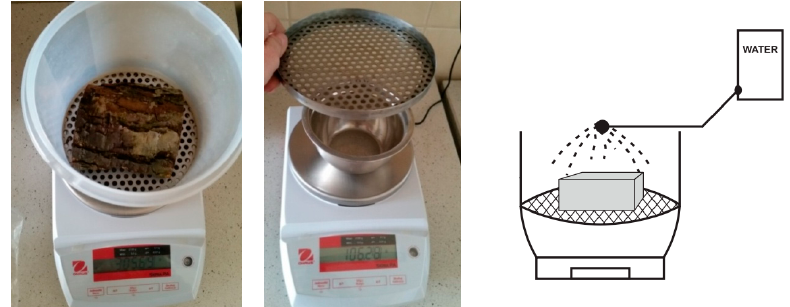
Figure 1. The water storage capacity measurement station and the analysis diagram.